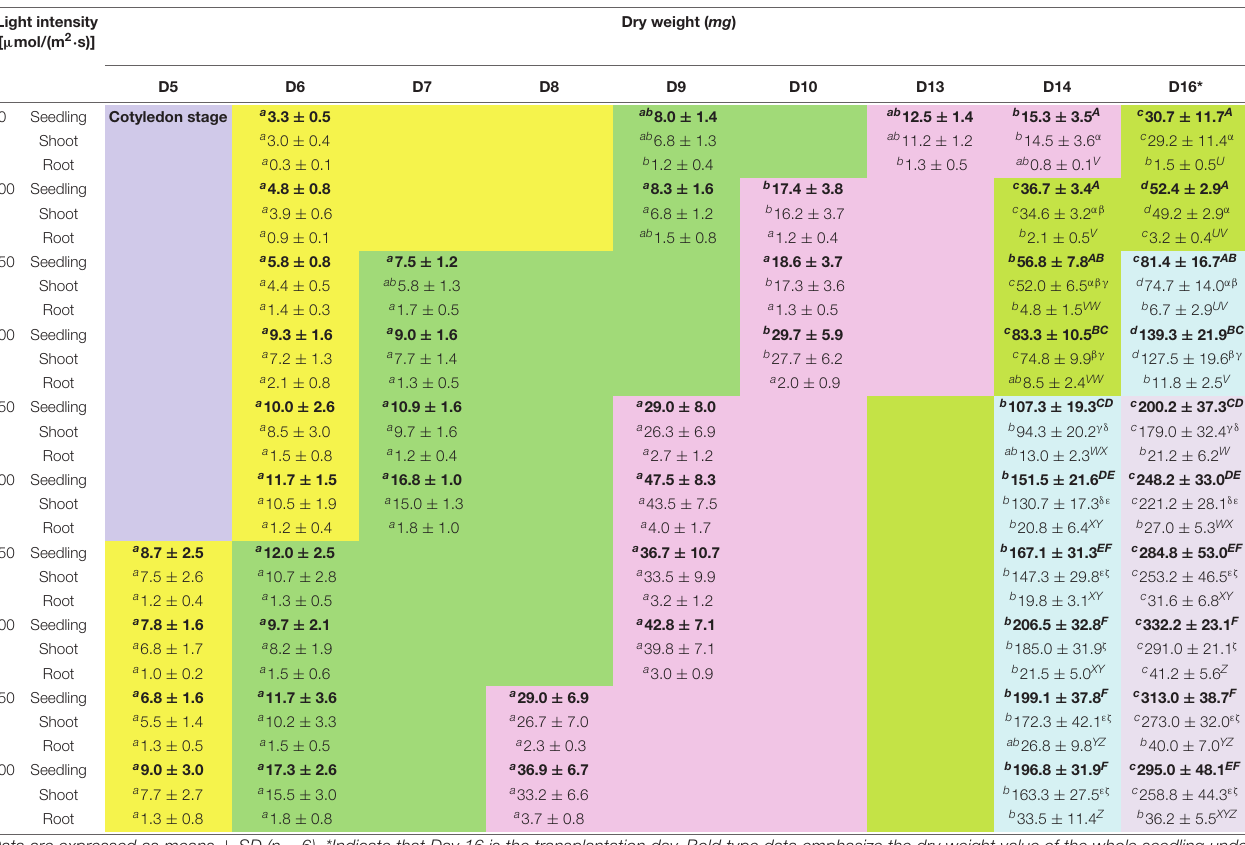
TABLE 3 | Dry weights of choy sum seedlings grown under different light intensities and growth stages. Light intensity [ µ mol/(m 2 ·